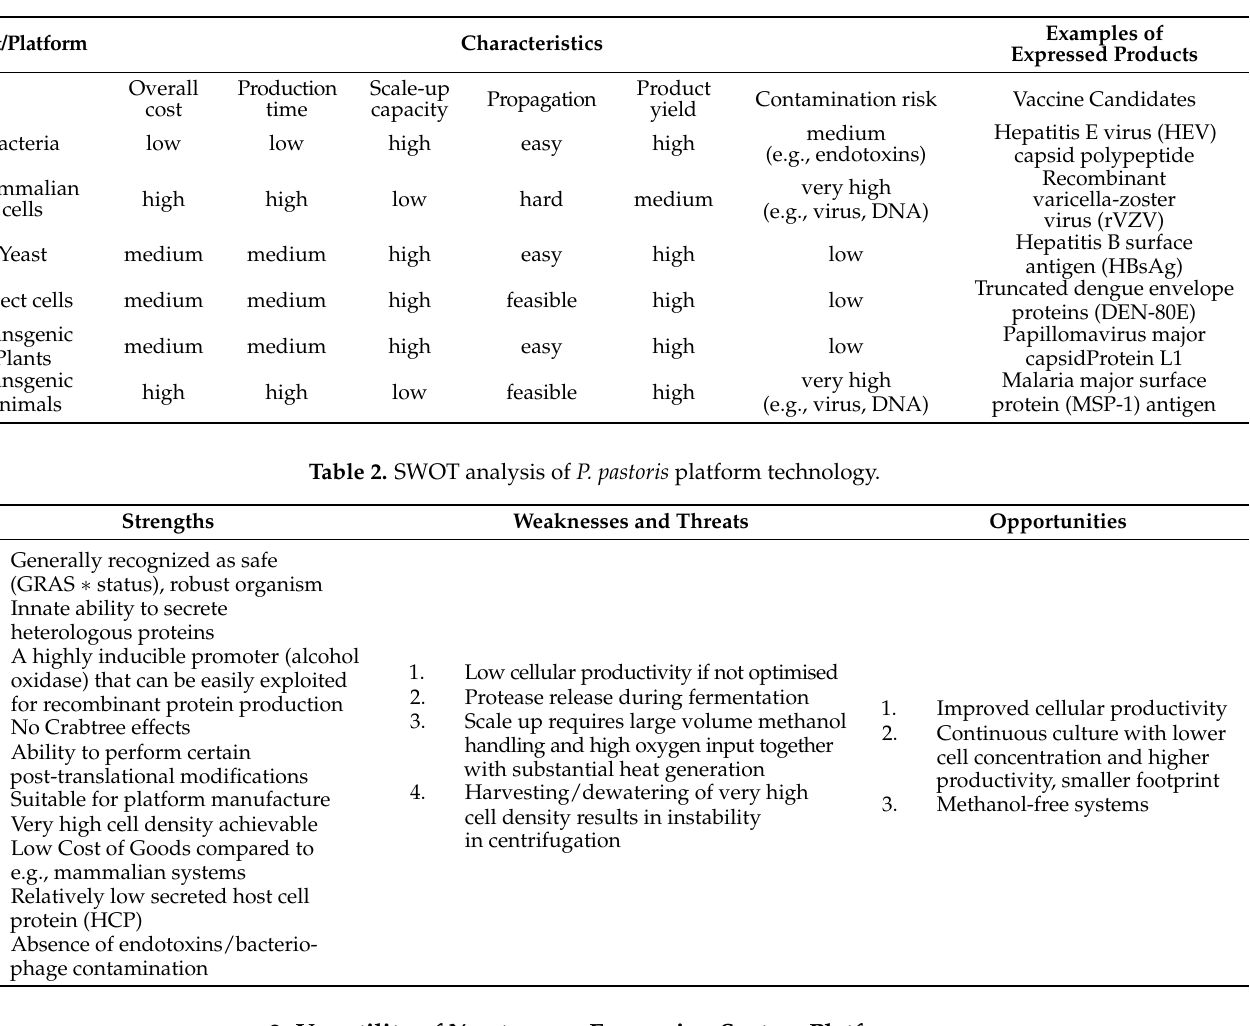
Table 1. Comparison of different expression systems for recombinant protein-based biopharmaceuticals production. Adapted from [10–13].